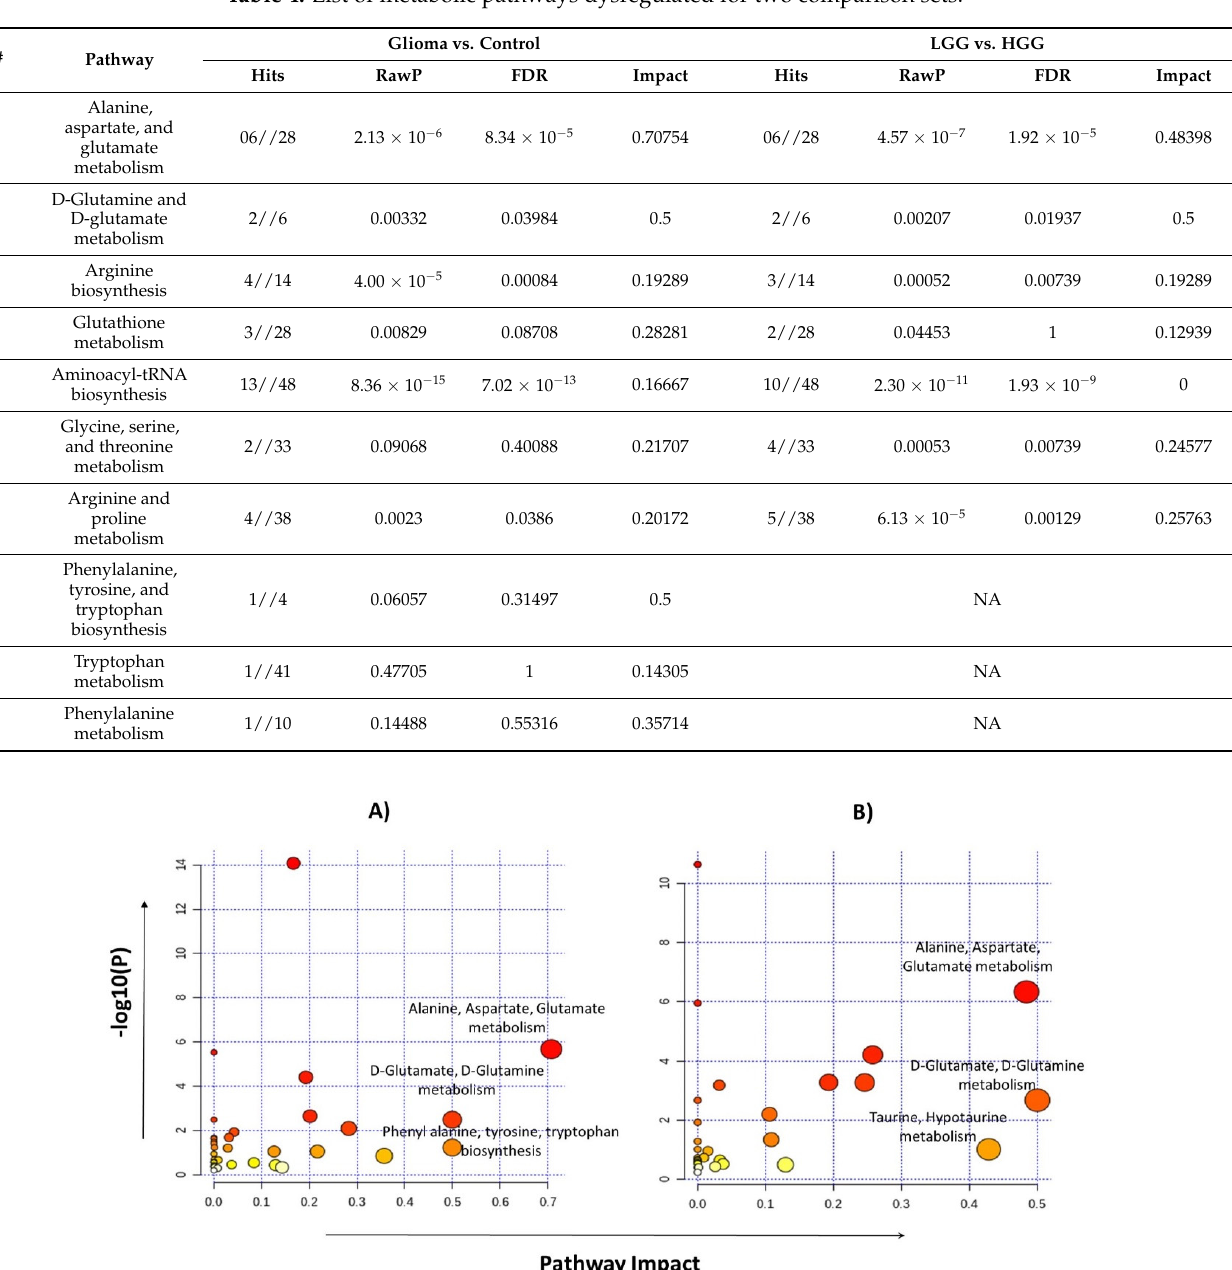
Table 4. List of metabolic pathways dysregulated for two comparison sets.